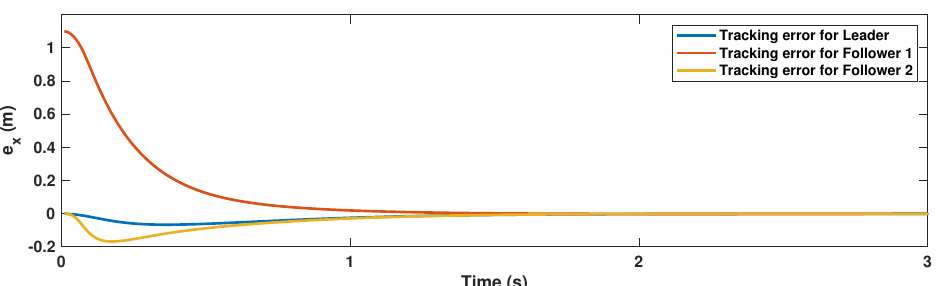
Figure 9. Path 2: The tracking performance.